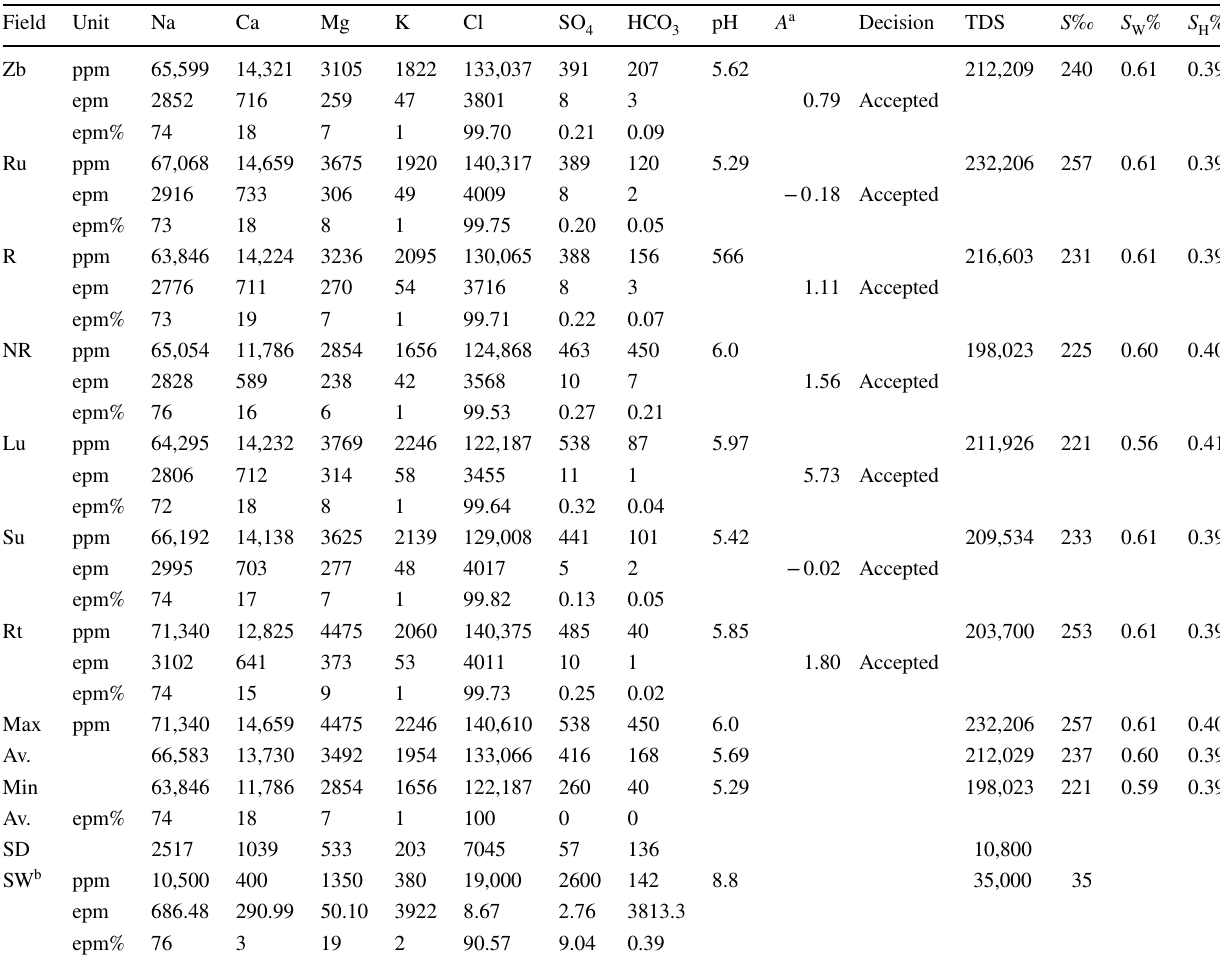
Table 1 Statistical results of Zubair brines in oilfields studied compared to